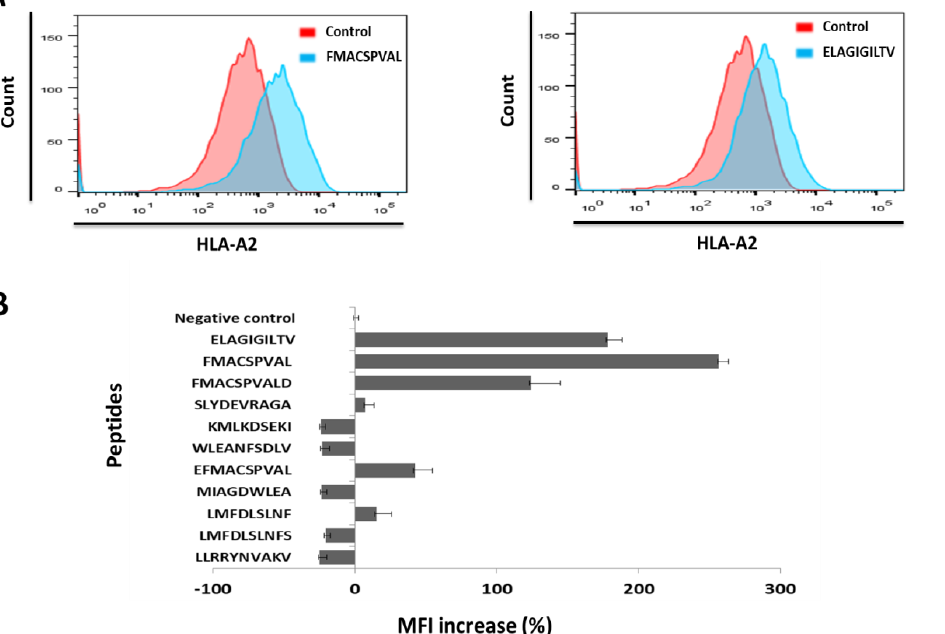
Figure 2. HLA-A*0201-binding affinity assay for different peptides on T2 cells (18 h). To evaluate the binding affinity of each candidate peptide to the HLA-A*0201 molecules, a T2 peptide-binding assay was performed. The upregulation of HLA-A * 0201 molecules on T2 cells may be detected by fluorescence intensity exchange, which reflects the peptide-binding ability to HLA-A*0201 molecules. The peptide ELAGIGILTV was used as a positive control, and cells without peptides were used as a negative control. ( A ) Flow cytometry results of peptides FMACSPVAL and ELAGIGILTV shown in red and the negative control shown in blue. ( B ) The binding activity of all 11 peptides to HLA-A*0201 molecules was determined semi-quantitatively by measuring the peptide-induced expression of HLA-A * 0201 on T2 cells with flow cytometry. Unloaded T2 cells were considered as a negative control. Mean values were calculated for each group; error bars indicate SD.